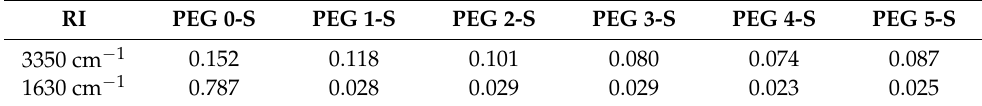
Table 4. Relative intensity of the peak at 3350 cm − 1 and 1630 cm − 1 for modified silica.